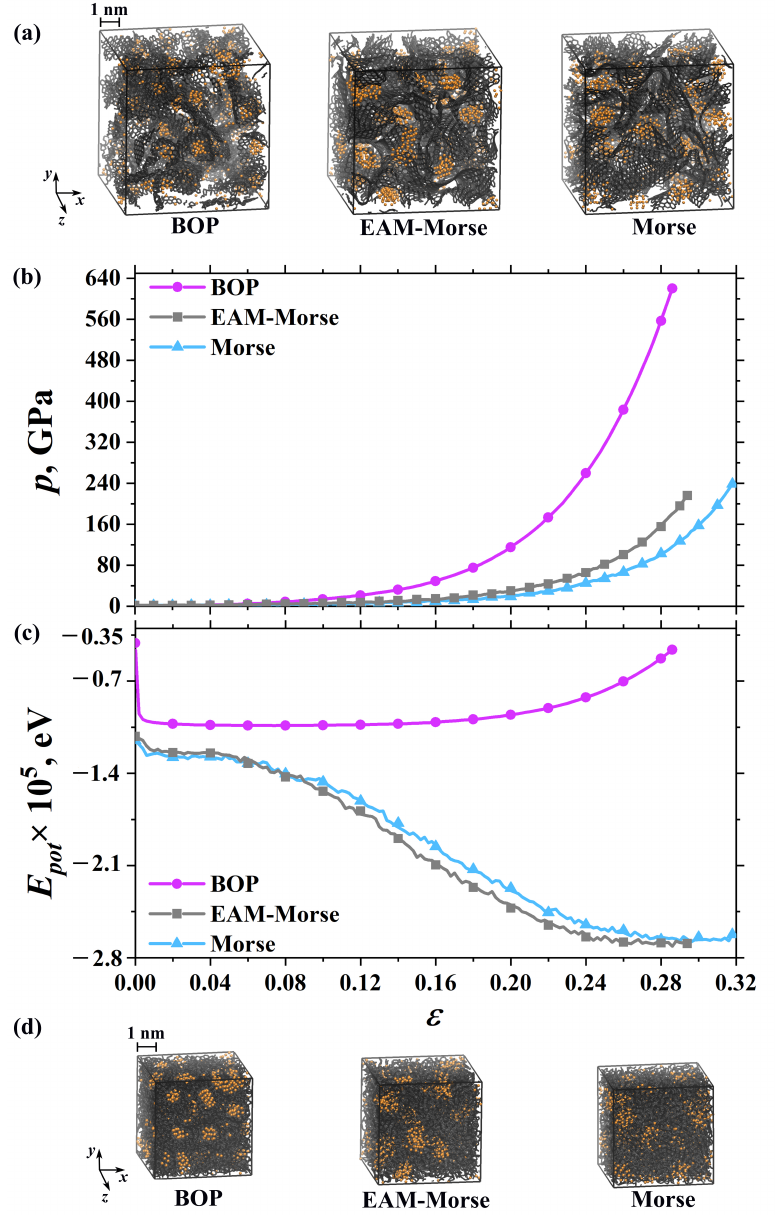
Figure 2. ( a ) Snapshots of the composite precursors obtained with different potentials after exposure at 300 K followed by hydrostatic compression. ( b , c ) Pressure and potential energy changes during hydrostatic compression. ( d ) Snapshots of the composite, obtained with different potentials. Cu atoms are shown in orange and C atoms are shown in